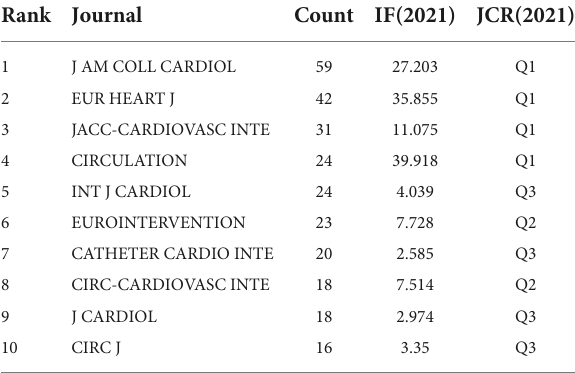
TABLE 1 The top 10 journals with the largest number of